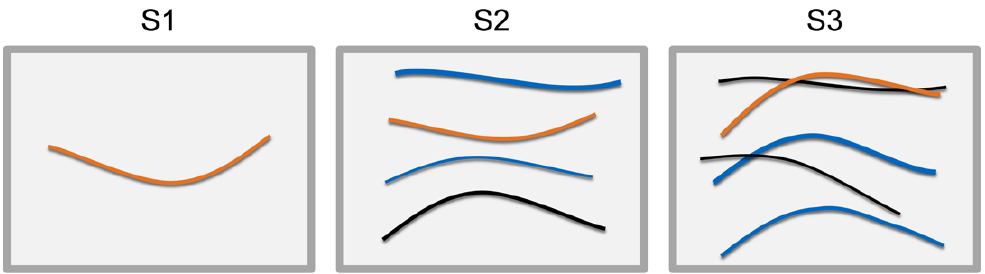
Figure 3. Representation of the three reference scenarios for the DLO